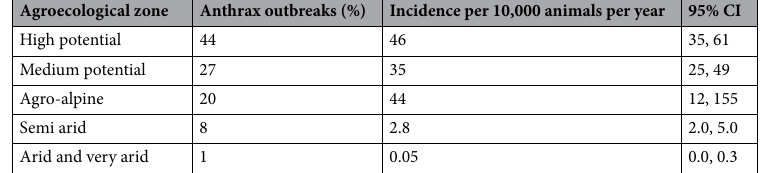
Table 3. Proportion and incidence of anthrax outbreaks by agroecological